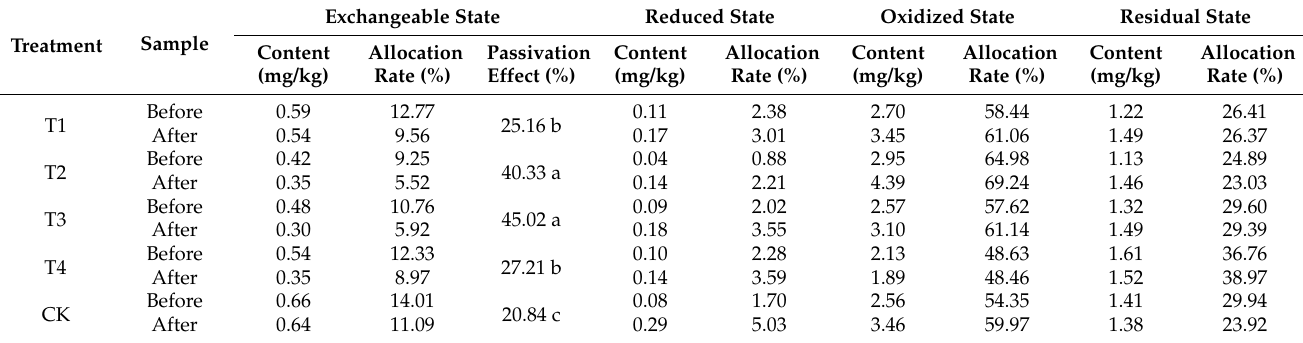
Table 6. Effect of biochar application on speciation of Pb during biogas residue composting.